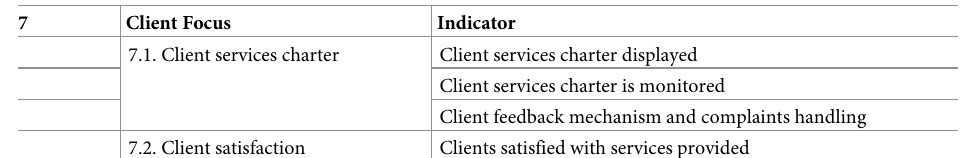
Table 1. Service area 7—client